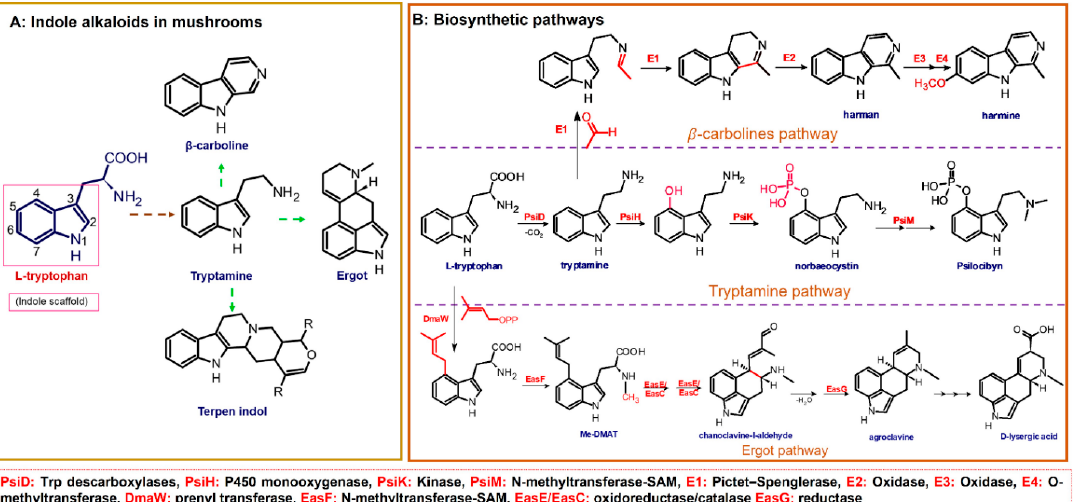
Figure 3. ( A ): Subclasses of indole alkaloids reported in mushrooms, ( B ): general overview of some fungal biosynthetic pathways for indole-derived alkaloids.